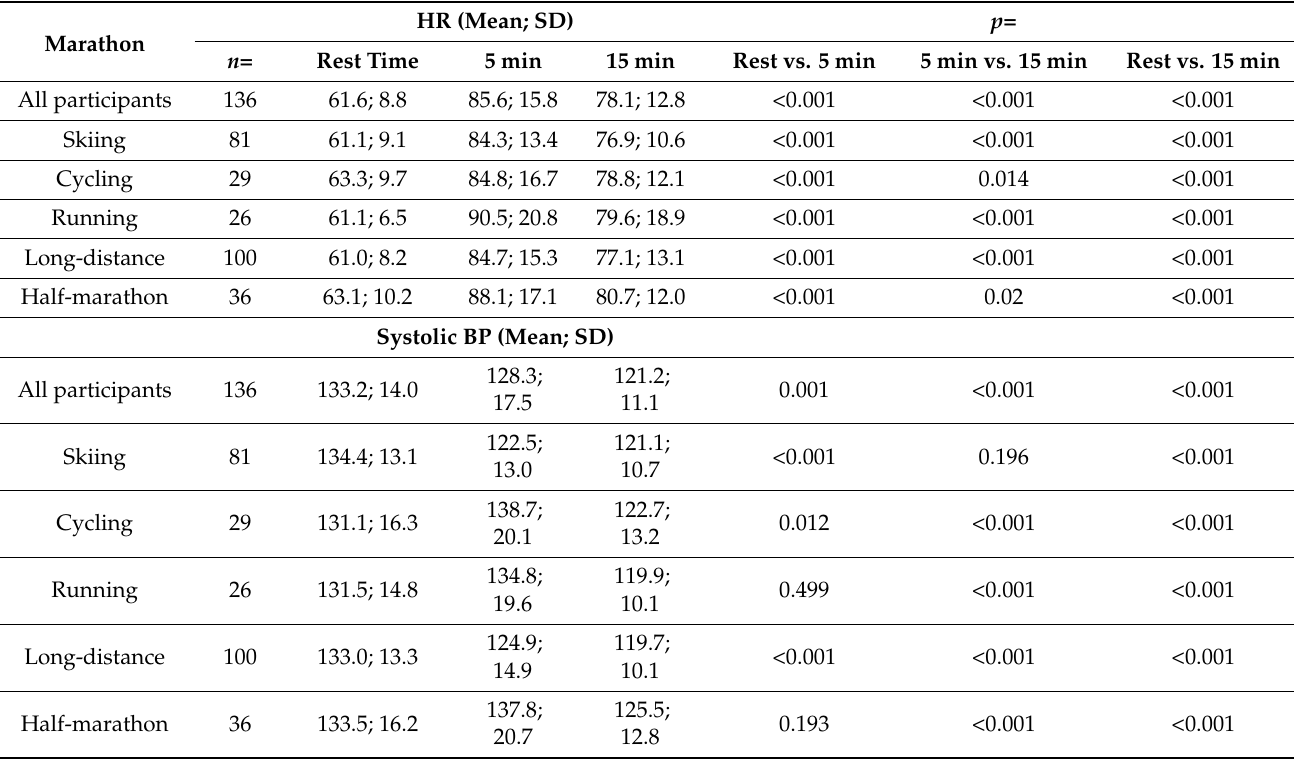
Table 2. Results of HR and BP prior to the marathon, 5 and 15 min after